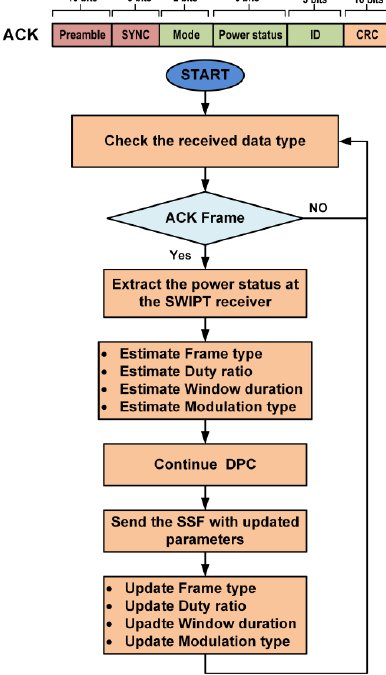
Figure 11. Structure of the acknowledgment (ACK) frame and the SWIPT control parameters updated at SWIPT transmitter.